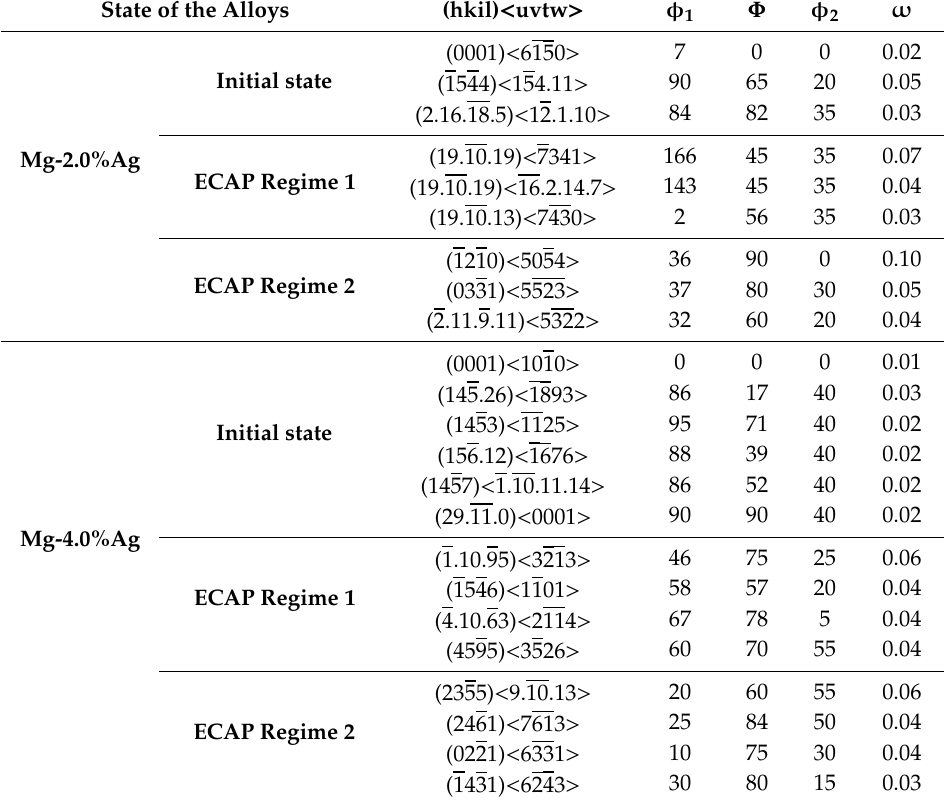
Table 2. The main orientations and their volume fractions for Mg-2.0%Ag and Mg-4.0%Ag alloys in the initial state and after ECAP. (The angles ϕ 1 , Φ and ϕ 2 are the Euler angles and ω the volume fraction of the respective orientation.).